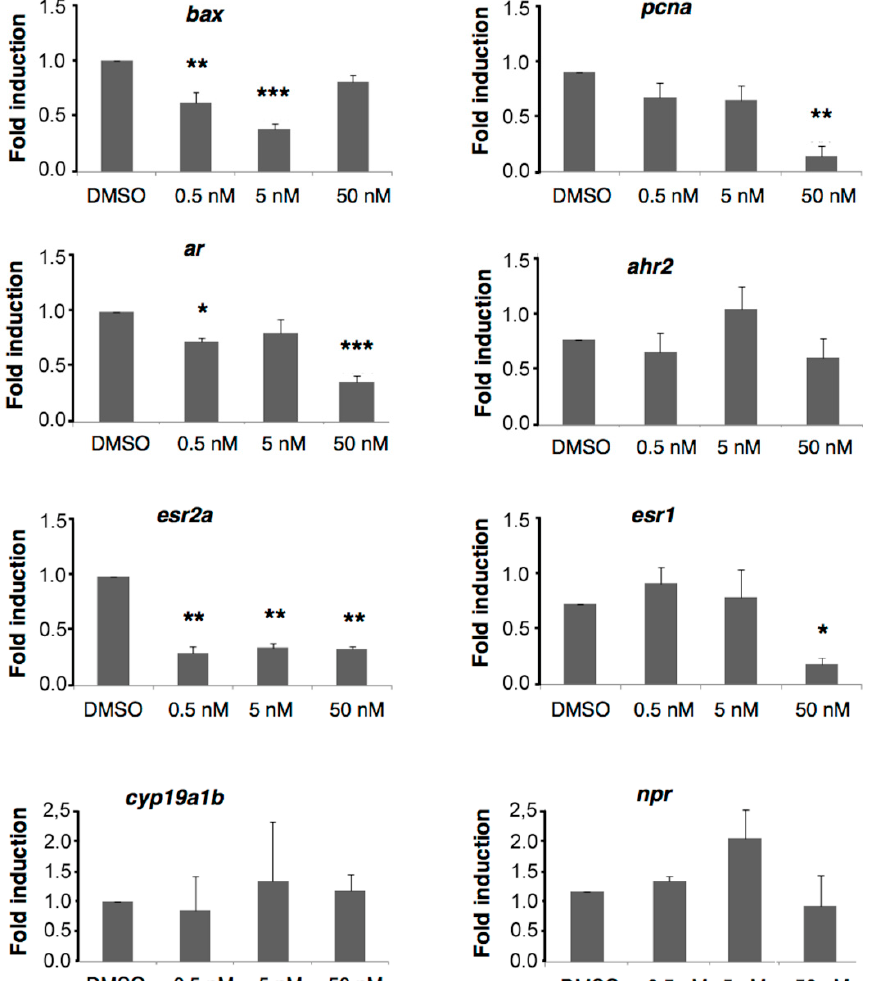
Figure 7. Relative gene expression of bax , pcna , ar , ahr2 , esr2a , esr1 , cyp19a1b and pr after exposure to A6. Relative transcript abundance was quantified by real-time reverse transcription PCR; the results are expressed as fold changes (log2) in mRNA abundance as compared to control values, as determined using the 2 ∆∆ C t method. Results are given as mean values ± SEM ( n = 6–9 replicates). Asterisks indicate significantly lower expression than control (* p < 0.05, ** p < 0.01, *** p < 0.001).